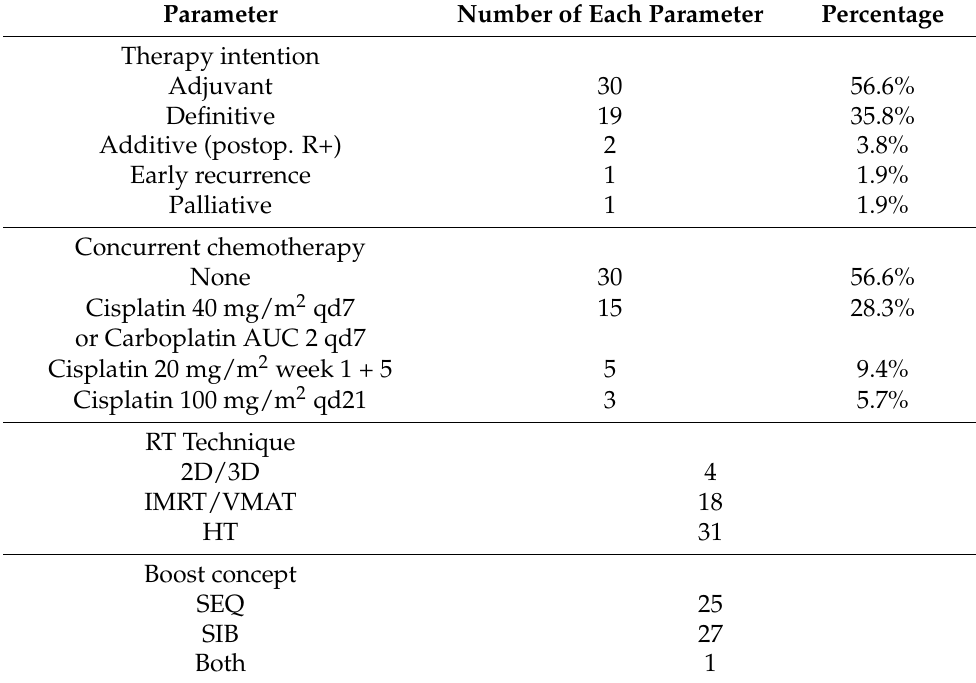
Table 2. Patient treatment characteristics ( n =